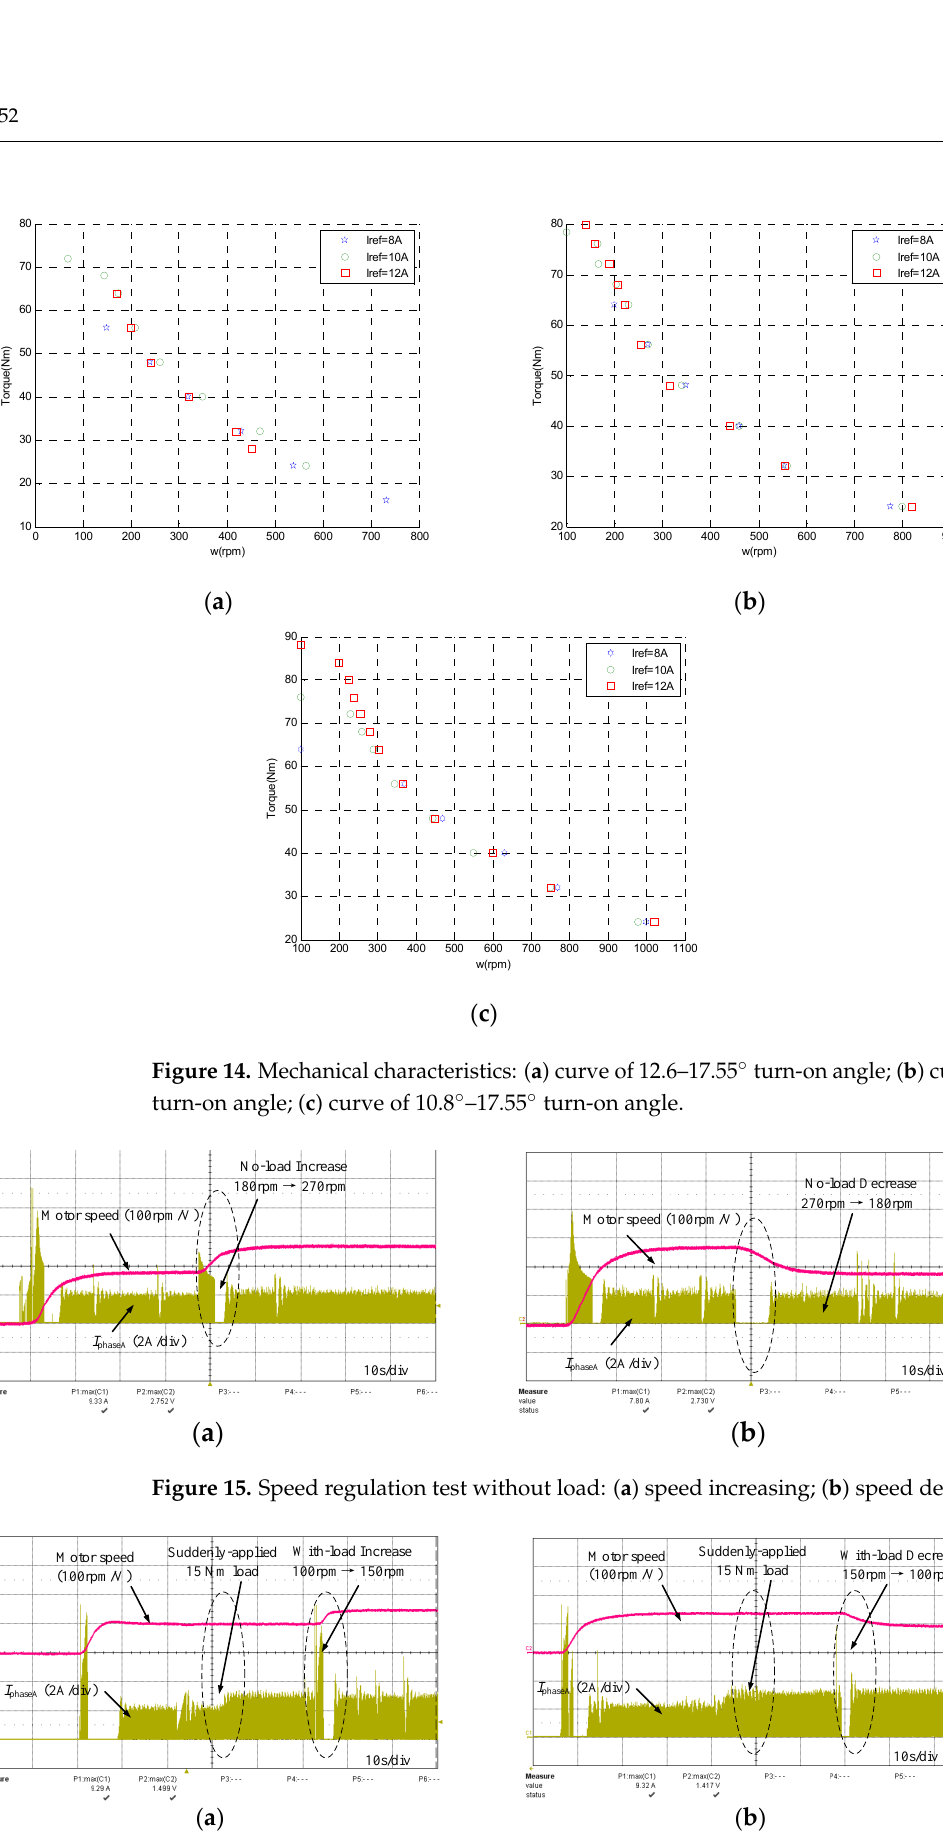
Figure 16. Speed regulation test with load: ( a ) speed increasing; ( b ) speed decreasing. 4.4. Torque Ripple Suppression Experiment Based on Step Current Excitation